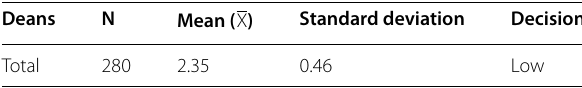
(awareness and practice) of the need for quality assurance in